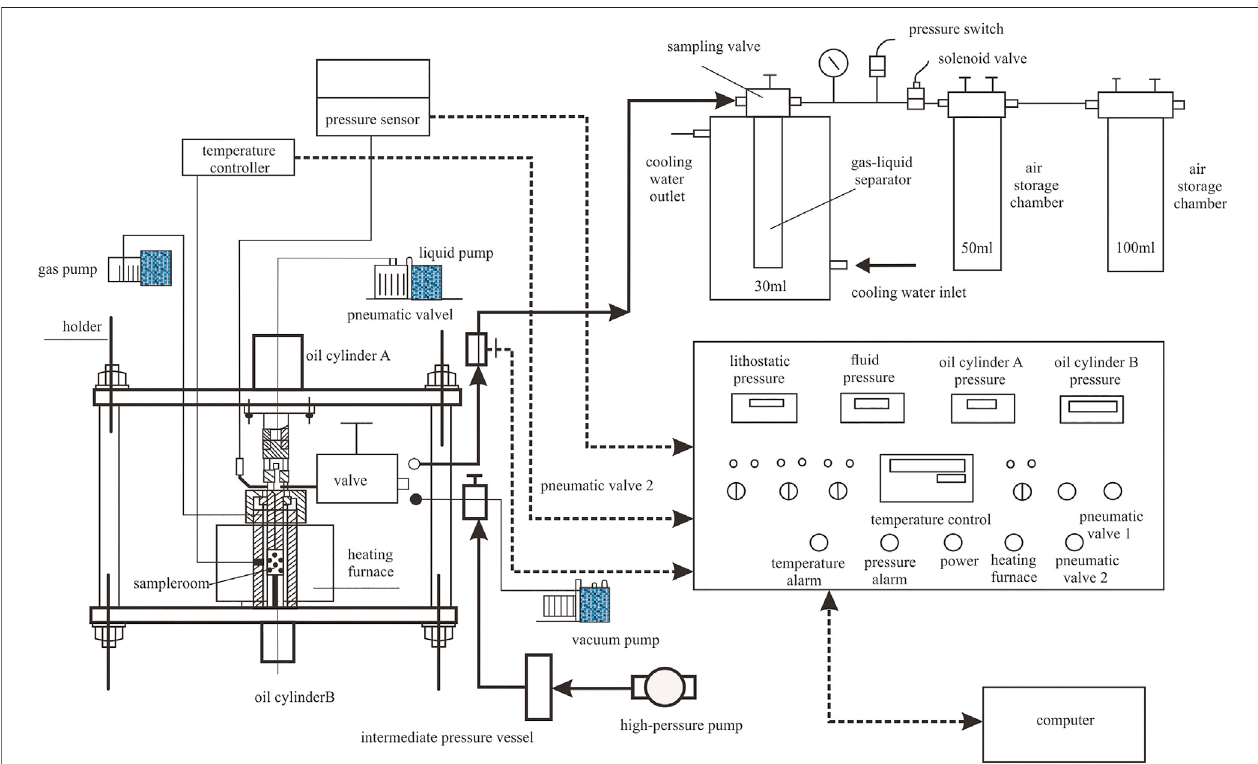
FIGURE 3 | Structure diagram of the thermocompression instrument for hydrocarbon generation and expulsion.